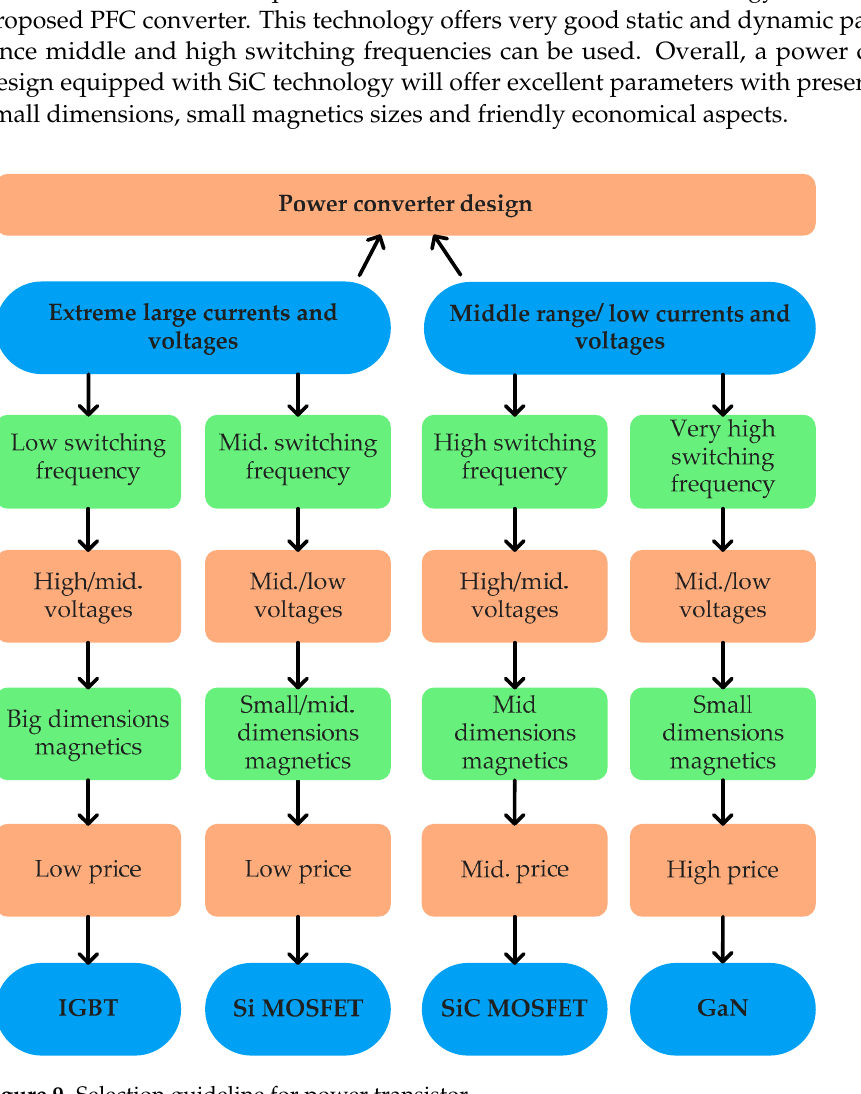
Figure 9. Selection guideline for power transistor.